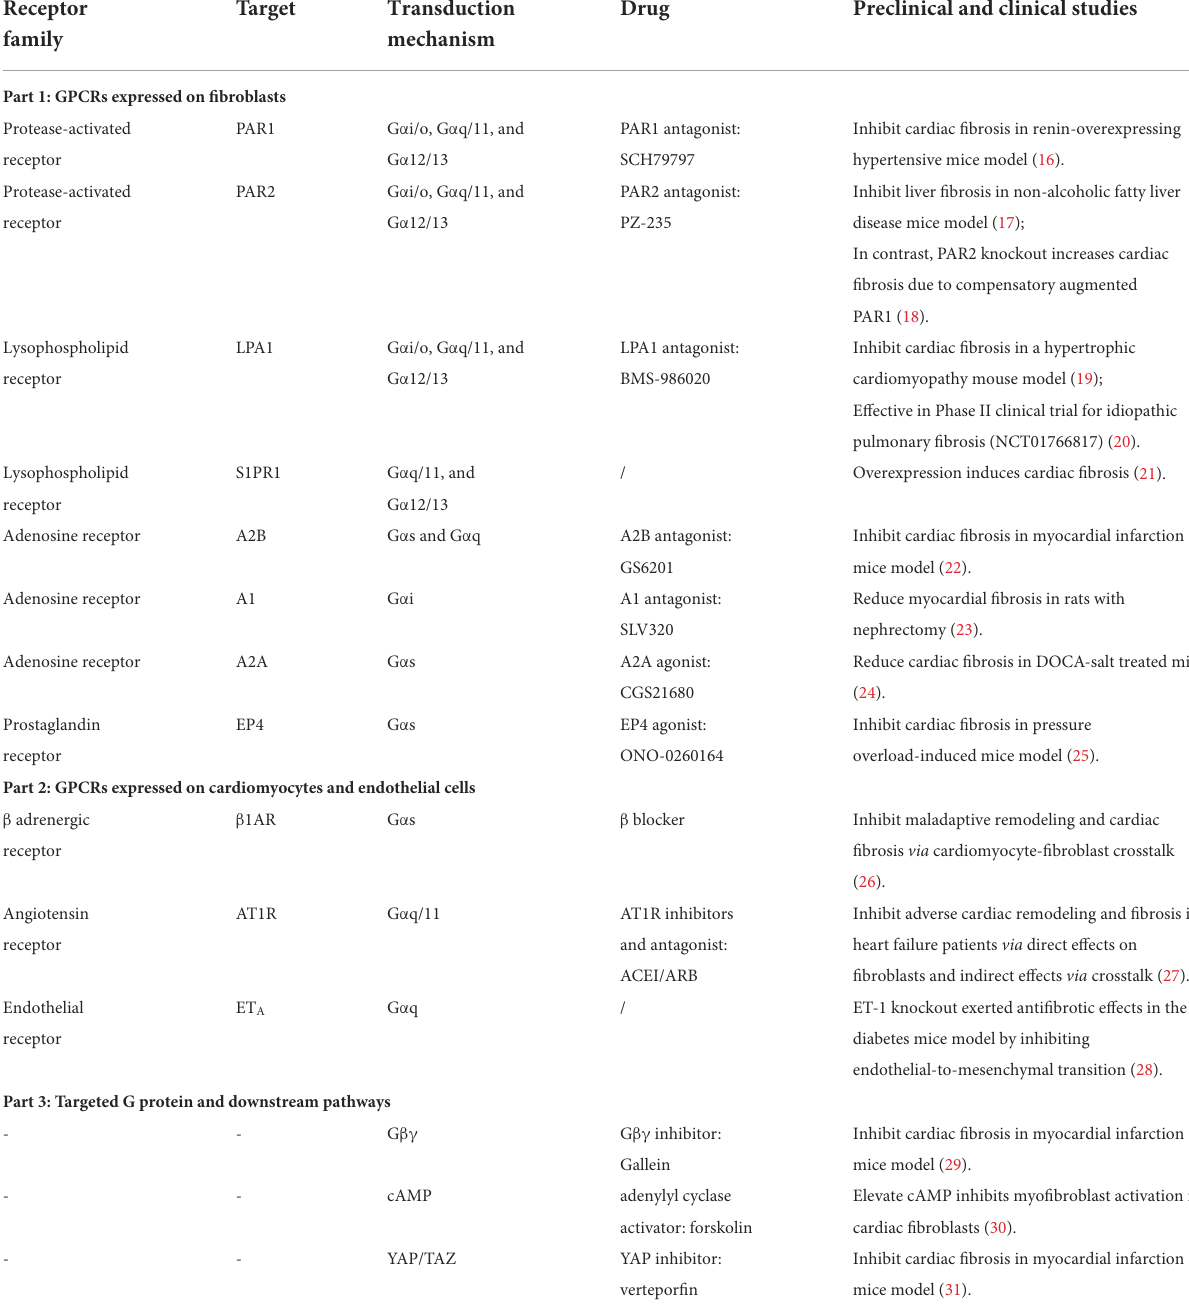
TABLE 1 Representative GPCRs and downstream pathways involved in fibrosis